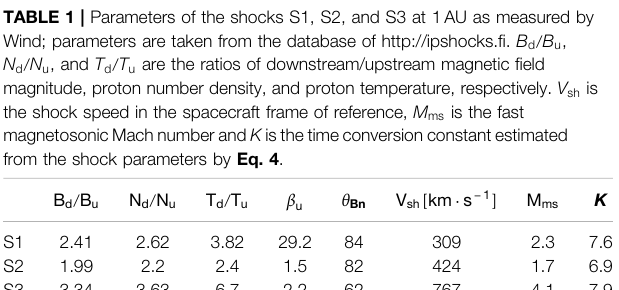
Frontiers in Physics |